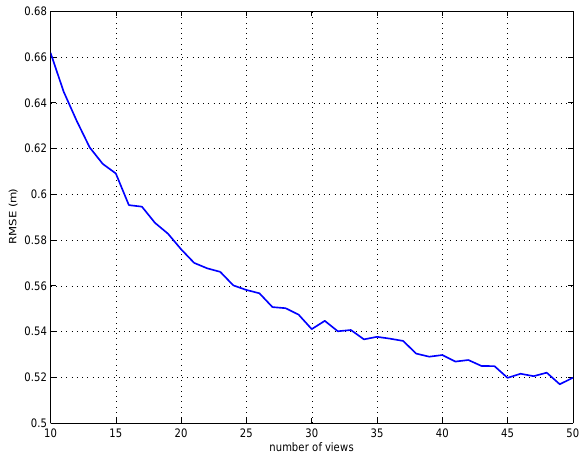
Figure 5: Estimation error of the georeferenced positions (RMSE) varying the number of camera views m